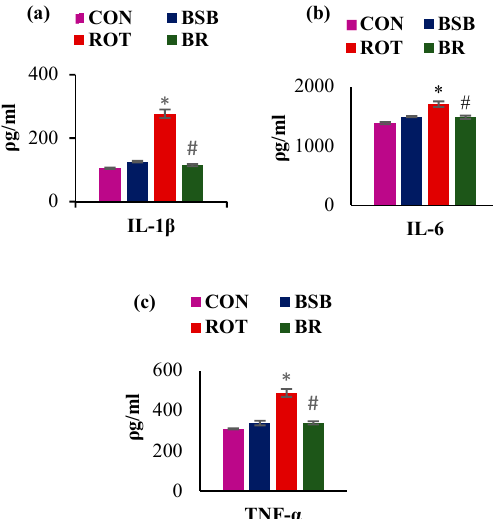
Figure 6. Concentration of proinflammatory cytokines IL-1 β ( a ), IL-6 ( b ), and TNF- α ( c ) in the mid brain of rats injected with ROT. There was a significant increase in the concentration of IL-1 β , IL-6 and TNF- α in ROT treated rats compared with control. However, BSB treatment to ROT injected rats significantly decreased these proinflammatory cytokines compared to ROT injected rats. There was no significant difference observed in the concentration of IL-1 β , IL-6 and TNF- α of BSB treated rats compared to control. The values are expressed as mean ± SEM (n = 6–7). * p < 0.05 CON vs ROT; # p < 0.05 ROT vs BR (One-way ANOVA followed by Tukey’s test).